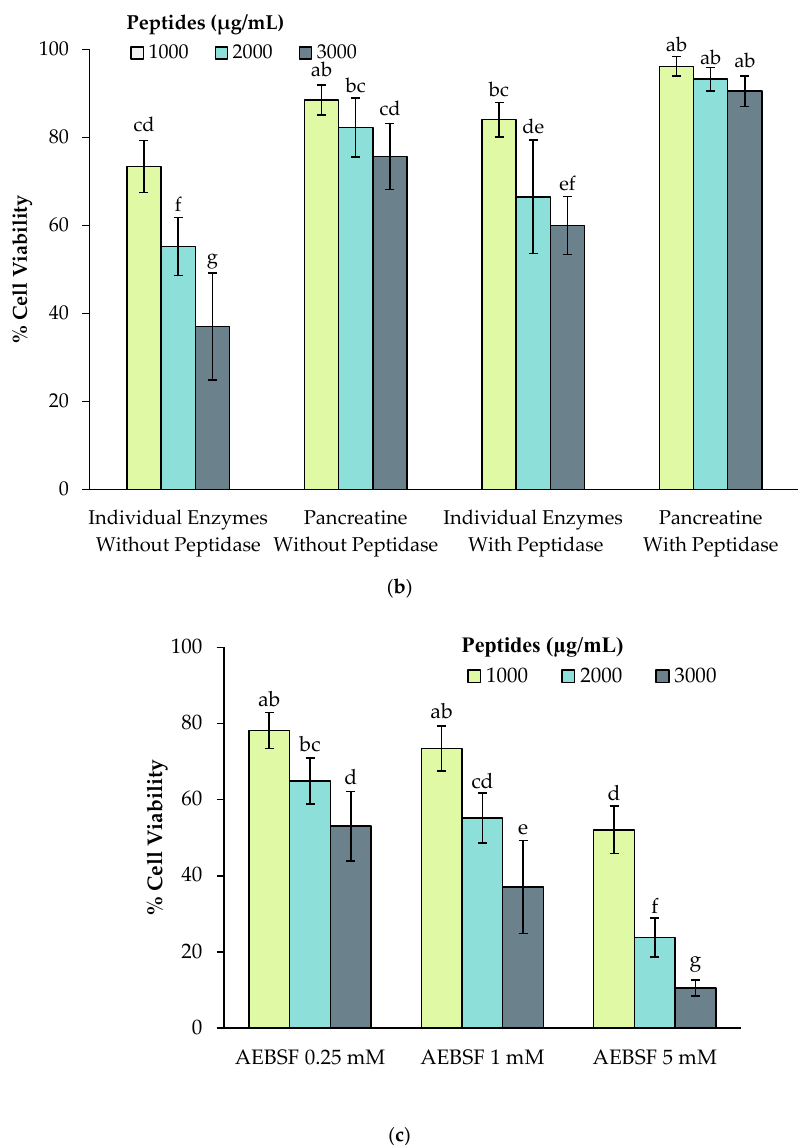
Figure 1. The impact of various concentrations (3000, 3500 and 4000 µ g peptides/mL) of 3 kDa permeate of faba bean digestate (variety Fabelle) obtained in different digestion conditions on Caco-2 cell viability. The digestions were performed with different ( a ) bile salts concentrations; ( b ) different intestinal enzyme combinations; ( c ) different protease inhibitor (4 ‐ (2 ‐ Aminoethyl) benzenesulfonyl fluoride hydrochloride (AEBSF)) concentrations. Data are expressed as mean ± standard deviation of three experiments and means without a common letter differ ( p < 0.05) as analyzed by two ‐ way ANOVA and the Tukey’s test.